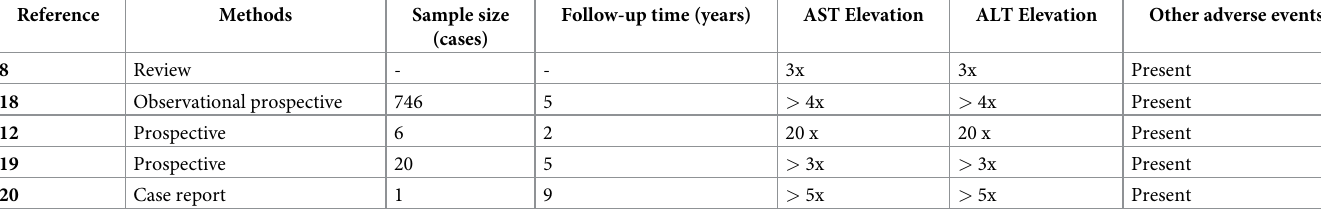
Table 2. Liver enzymes elevation and presence of other adverse events to benznidazole in literature